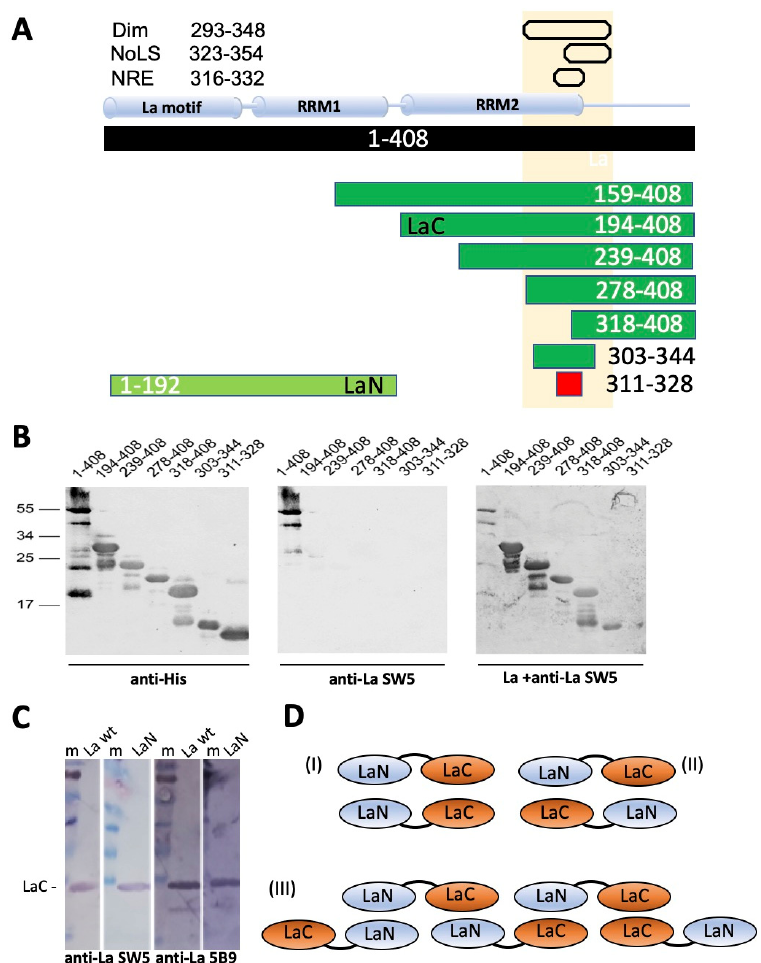
Figure 5. Dimerization of La protein. Craig et al. reported [14] that La protein contains a dimerization domain (Dim). Within the same region, an NRE [15] as well as a NoLS [16] was identified in independent studies. Structural data argue against a dimerization of La protein [15]. The epitope region recognized by the anti-La mAb 7B6 is also part of the predicted Dim domain and consists mainly of the α 3-helical domain in the RRM2. ( A ) La fragments truncated either from the N- or C-terminus or from both sites, including the epitope region recognized by the anti-La mAb 7B6 (aa311-328), were expressed in E. coli as His-tagged proteins and purified by nickel affinity chromatography. ( B ) Far-Western blotting analysis was performed. All La-related fragments were separated by SDS–PAGE, and their presence was verified by immunoblotting using an anti-His Ab ( B , anti-His). None of the fragments, but full-length wild-type La protein ( B , 1–408) reacted with the anti-La mAb SW5 ( B , anti-La SW5), which requires N- and C-terminal portions of the RRM1 domain for reactivity [49,50]. Incubation of the blotted La fragments with full-length La protein leads to a stable protein–protein interaction, which could be detected with the anti-La mAb SW5 (La +anti-La SW5). Using this modified Far-Western blotting assay, we identified the fragment aa303-334 as the smallest fragment, which is still able to interact with full-length La protein. ( C ) The LaN fragment (aa1-192) lacks the Dim domain. Still, after Far-Western blotting, binding of LaN to LaC was detected by both the anti-La mAb SW5 and 5B9. ( D ) (I) According to these data, besides the proposed head–head/tail-tail dimers [14] also head to tail dimers (II) should be possible and also a mixture of oligomers and even polymers may be formed